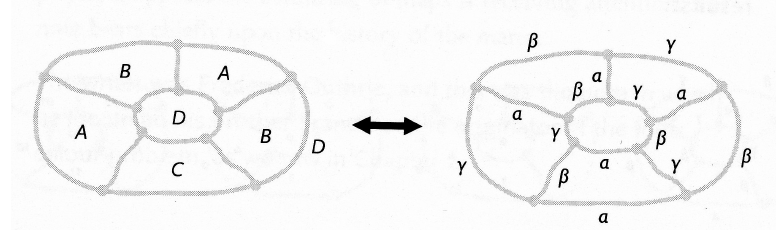
Figure 2: 4 -coloring the countries of a cubic map is equivalent to 3 -coloring the edges.